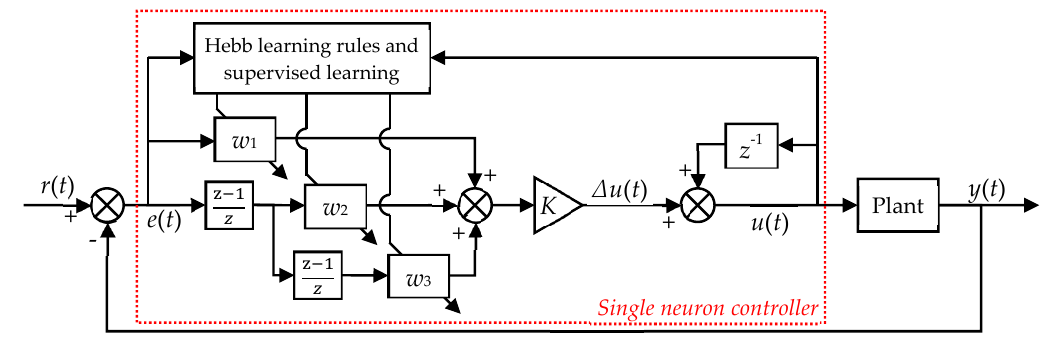
Figure 3. Schematic diagram of the single-neuron adaptive hysteresis compensation method.